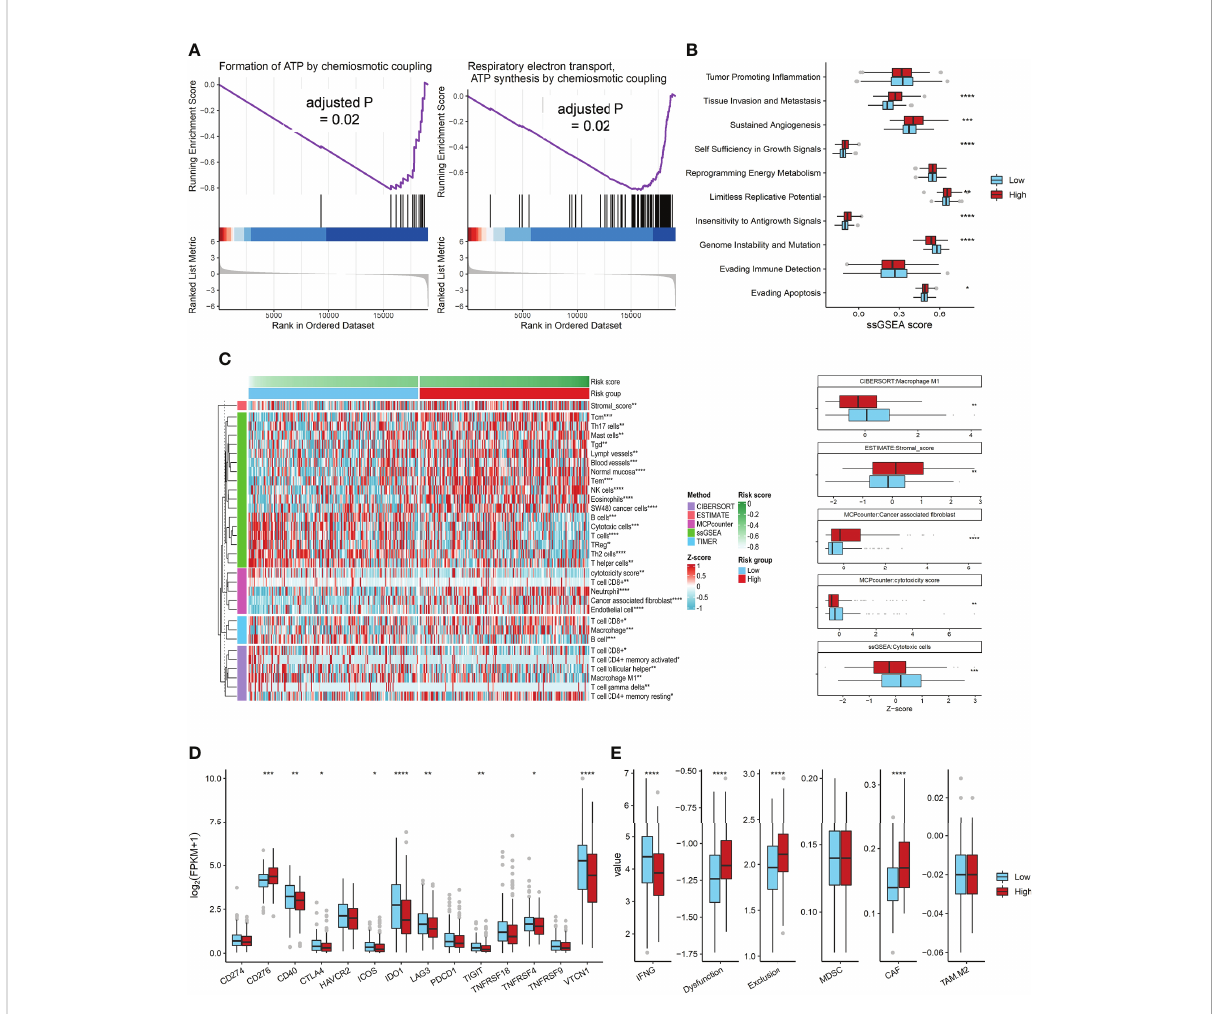
FIGURE 4 The Association of ADO score with biological signatures or immune genes expression in TCGA dataset. (A) Two signi fi cantly enriched ATP synthesis pathways in the low ADO group by GSEA; (B) Boxplots of the ssGSEA score of 10 cancer hallmarks signatures between two ADO groups; (C) Heatmap and boxplots of the in fi ltrated immune signatures score based on fi ve algorithms; (D) Boxplots of immune checkpoint genes expression between two ADO groups; (E) Boxplots of the T cells dysfunction and exclusion signatures from TIDE algorithm between two ADO groups. (*P < 0.05, **P < 0.01, ***P < 0.001, ****P <